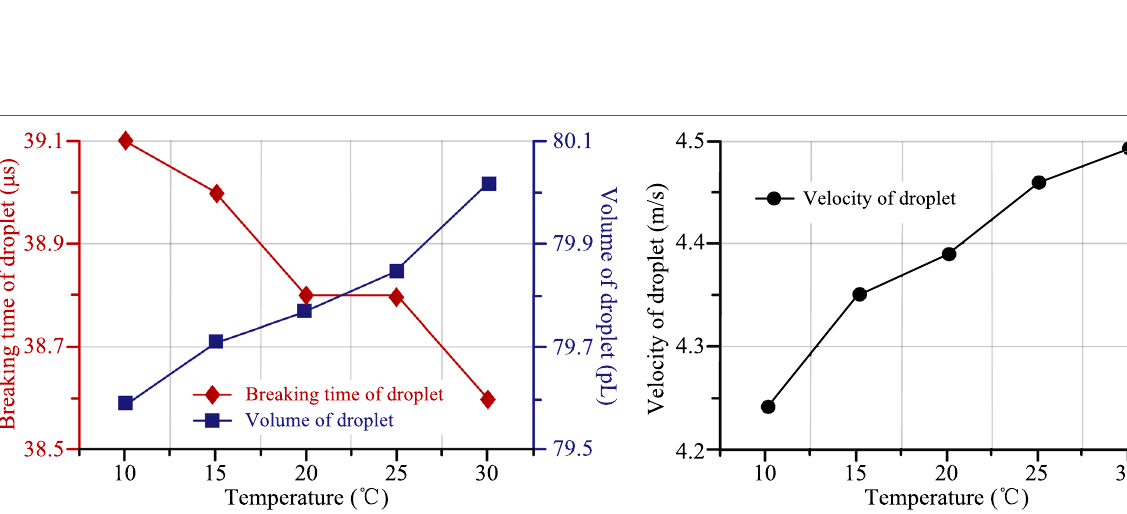
Figure 12 The relationship among breaking time of droplet, volume of droplet, velocity of droplet and liquid temperature